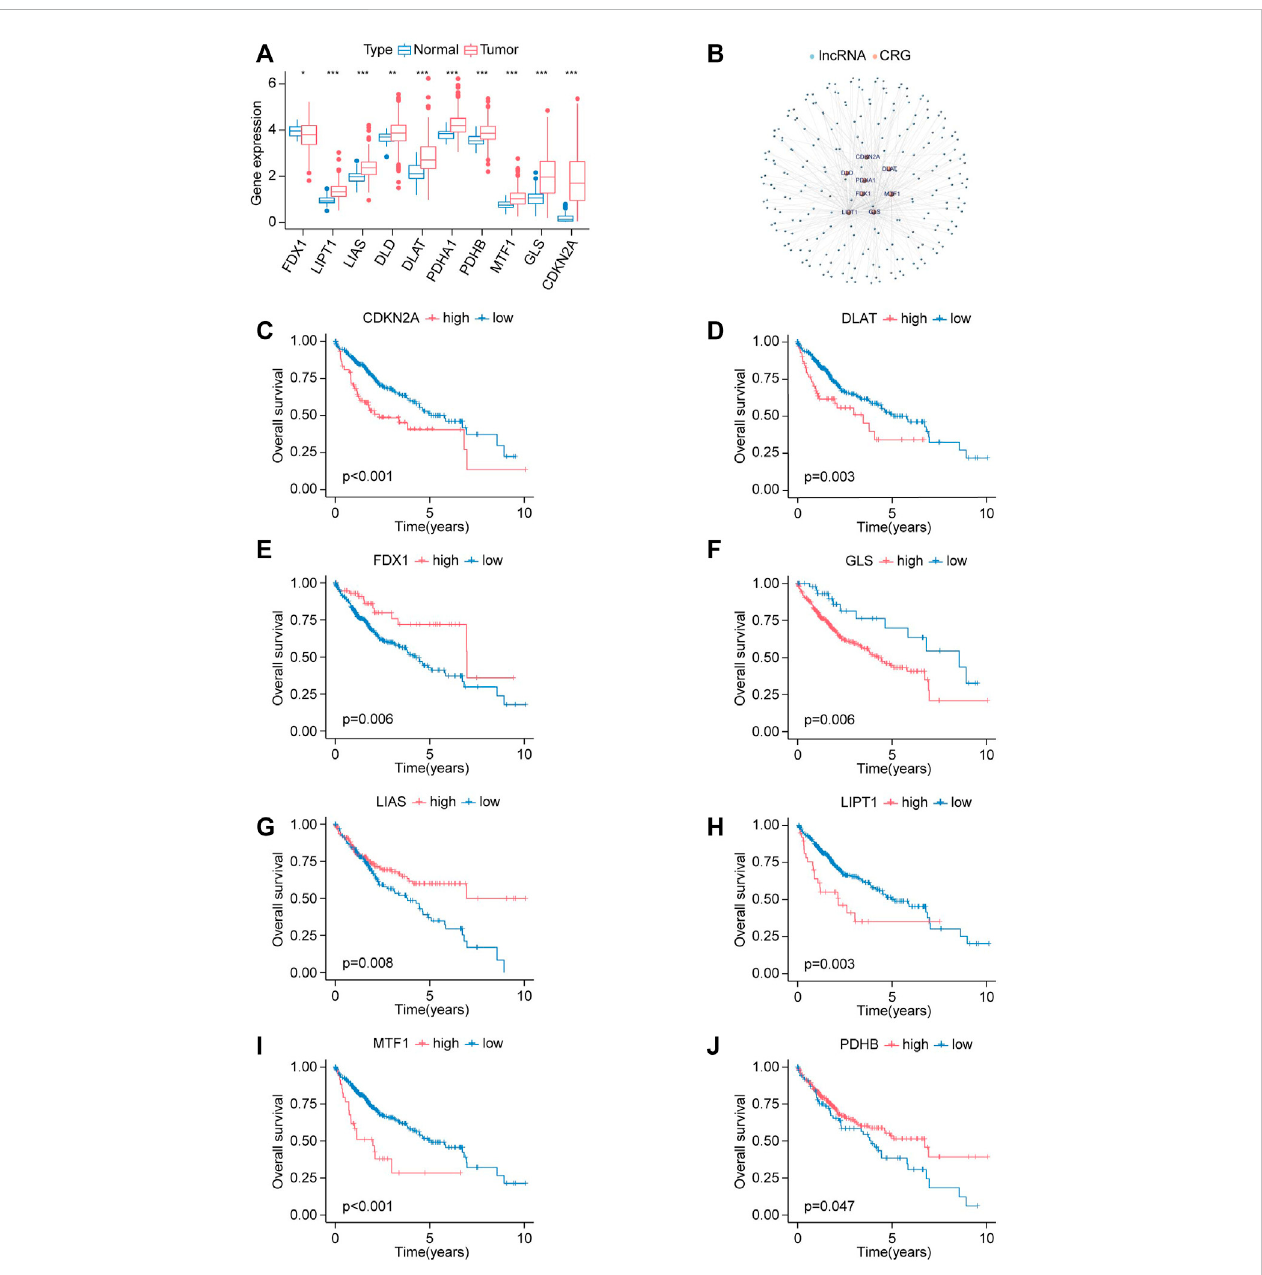
FIGURE 3 Expression signature and prognostic analysis of CRGs in HCC. (A) The expression status of CRGs in HCC presented in box plot. Tumor labeled with red color, normal tissue labeled with blue color. * p < 0.05, ** p < 0.01, *** p < 0.001. (B) Co-expression network of lncRNAs and cuproptosis-related genes. (C – J) Thesurvivalcurvesforhigh-expressionandlow-expressiongroupsareclassi fi edbytheexpressionlevelsofCRGs. (C) CDKN2A . (D) DLAT . (E) FDX1 . (F) GLS . (G) LIAS . (H) LIPT1 . (I) MTF1 . (J) PDHB